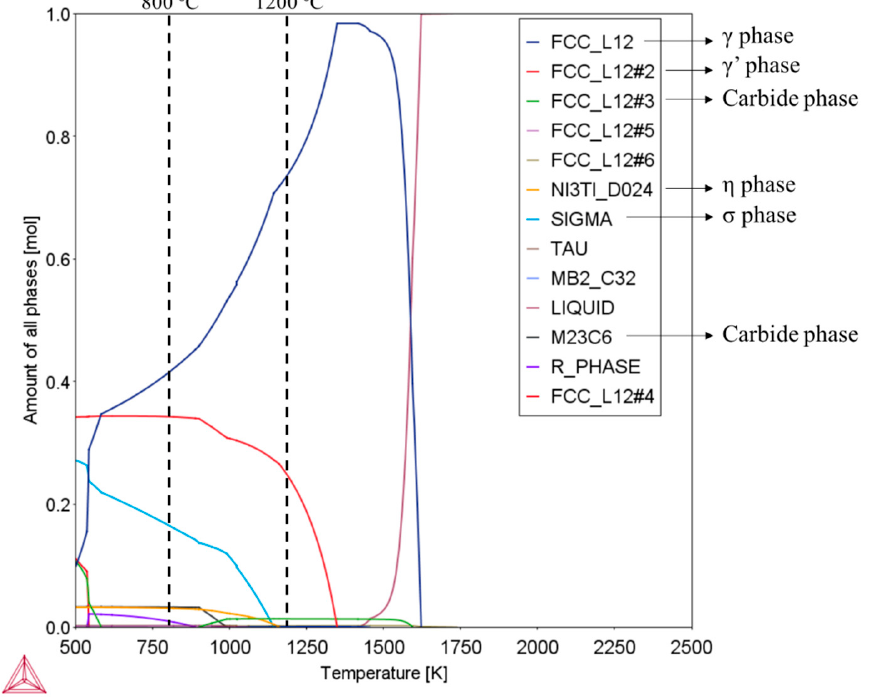
Figure 3. The number of different phases at different temperatures for Inconel 939 alloy obtained from CALPHAD calculation.